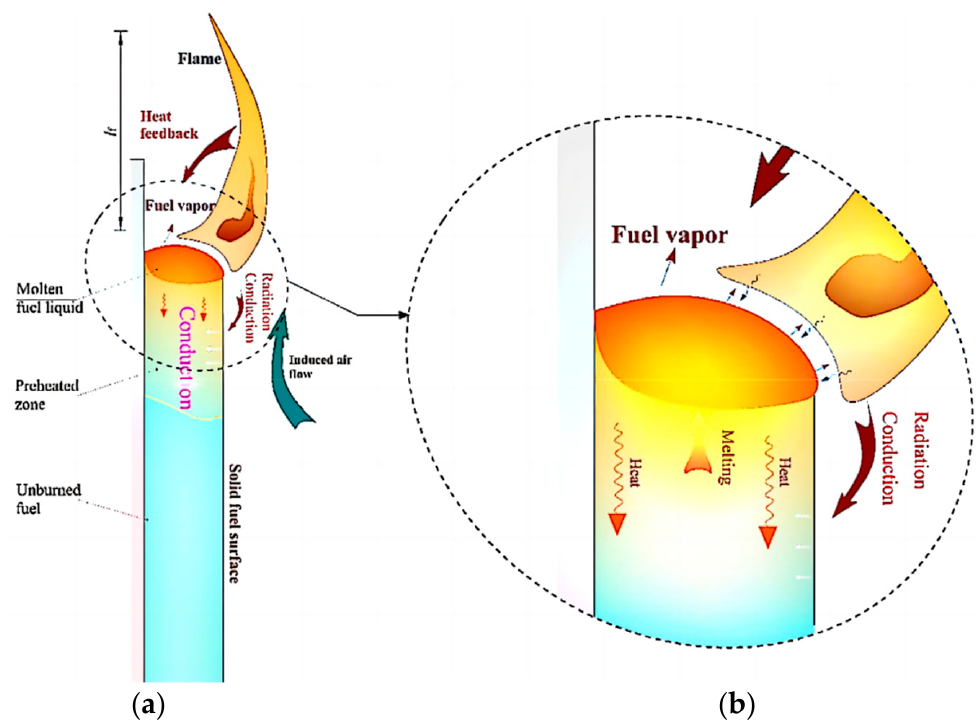
Figure 1. ( a ) An illustration of the mass and heat transfer for XPS’s flame downward spread; ( b ) the little pool fire caused by the development of a layer of melting liquid on the surface of the vertical- oriented XPS [63].